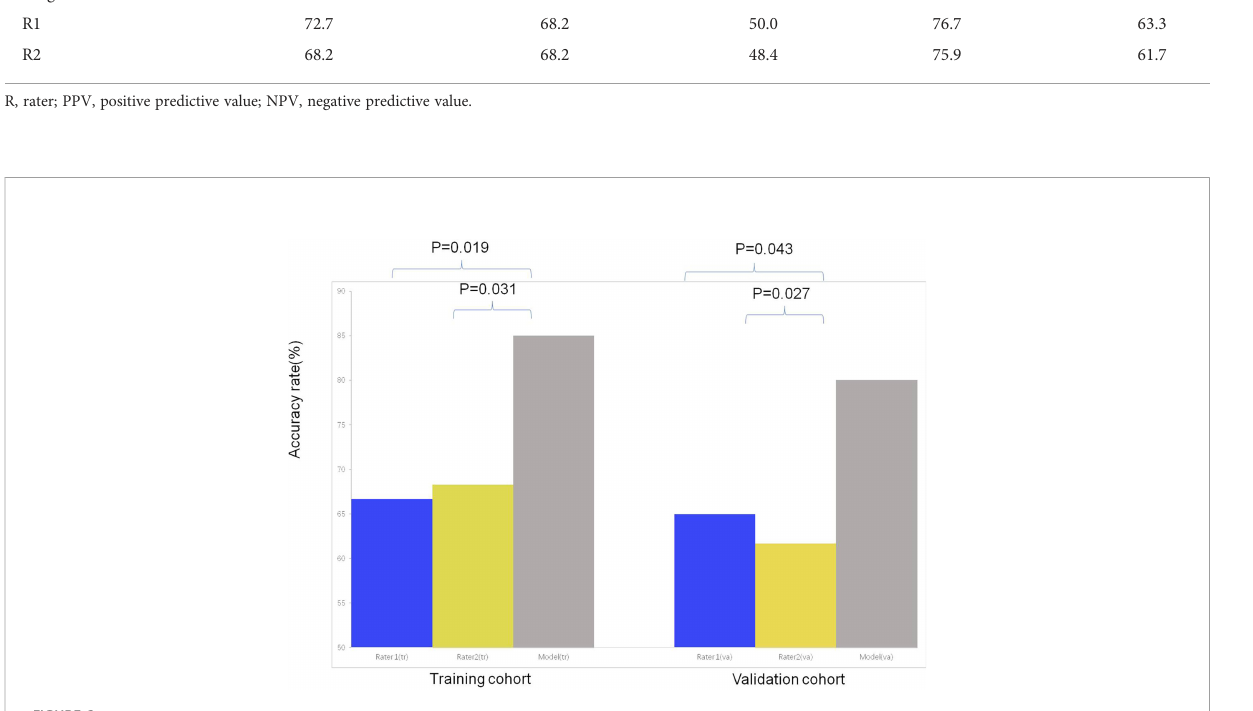
FIGURE 6 The comparison of the accuracy among subjective evaluation and subjective evaluation with the assistance of diagnostic model for differentiating LC from LM of